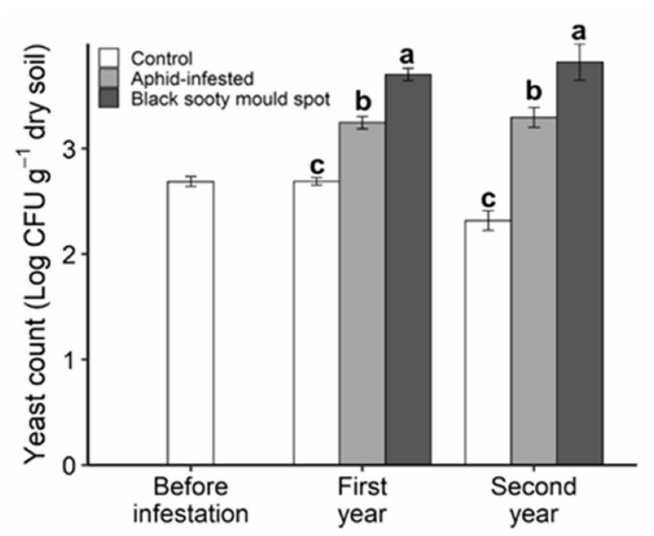
Figure 6. The yeast colony forming units (CFU) per gram of dry soil, collected under the canopies of willow plants prior to aphid inoculation (before infestation), and after aphid inoculation (control, aphid-infested, and black sooty mould spots) in the first and second year. The values are the means ± SE. Di ff erent letters indicate statistically significant di ff erences at each sampling time (Tukey’s HSD test, α =